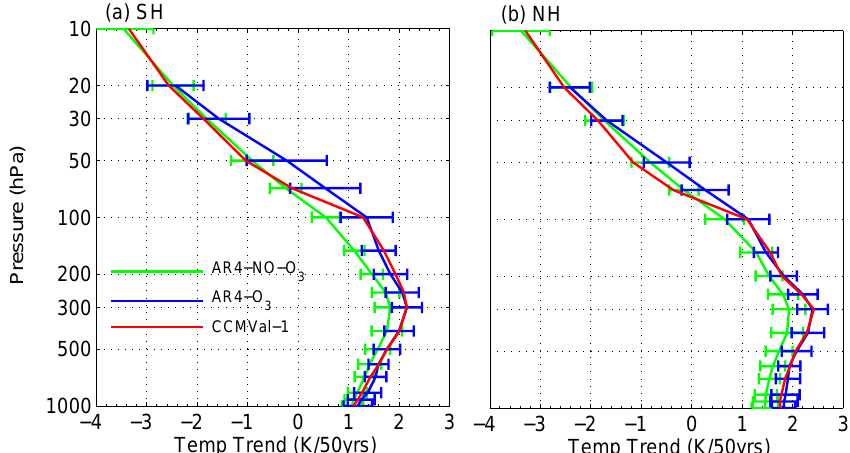
Fig. 4. Same as Fig. 2a, except for annual and hemispheric mean temperature trends. (a) NH and (b) SH. and interactive ozone recovery. The difference may also be